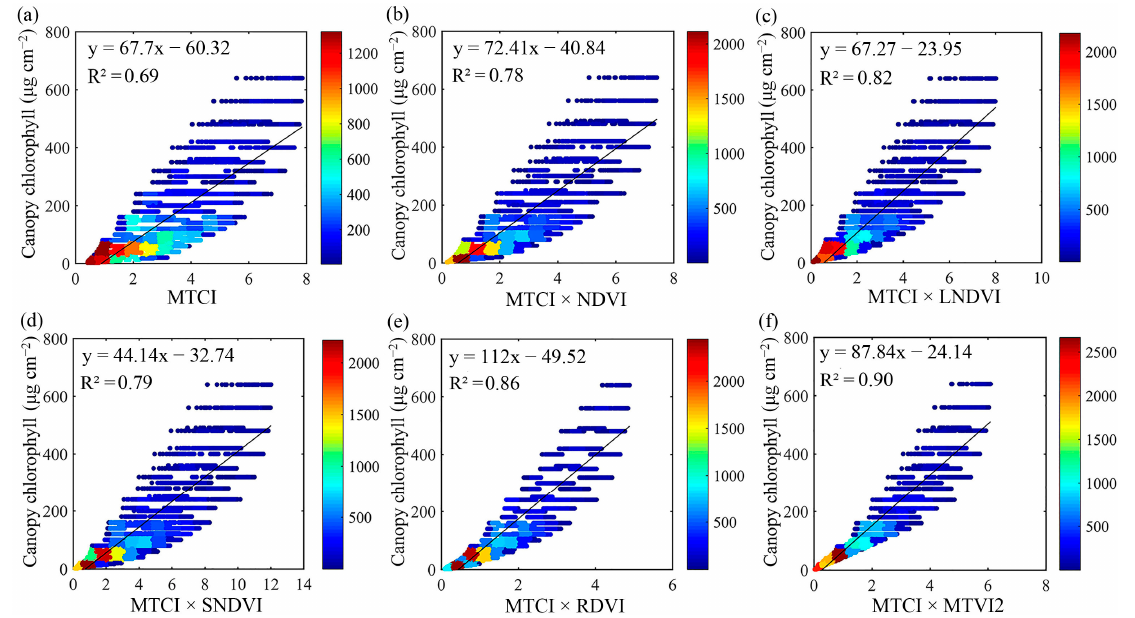
Figure 6. The relationships between CCC and ( a ) MTCI, ( b ) MTCI × NDVI, ( c ) MTCI × LNDVI, ( d ) MTCI × SNDVI, ( e ) MTCI × RDVI, and ( f ) MTCI × MTVI2 for the simulation dataset, respectively. The color bar represents the dot density. Table 6. Binary linear regression retrieval model.